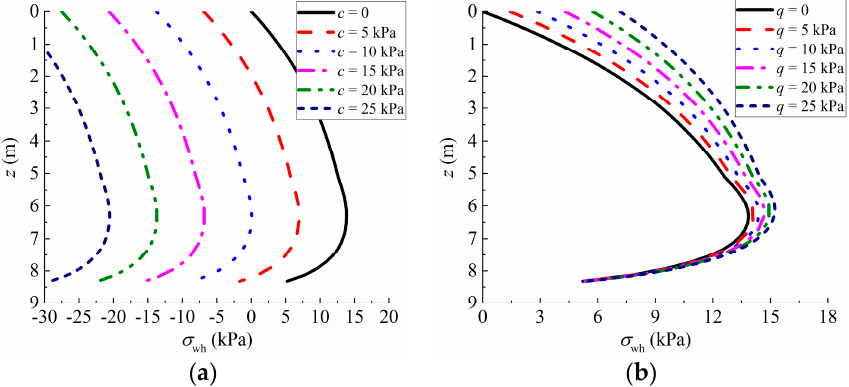
Figure 13. Influence of ( a ) c and ( b ) q on σ wh .